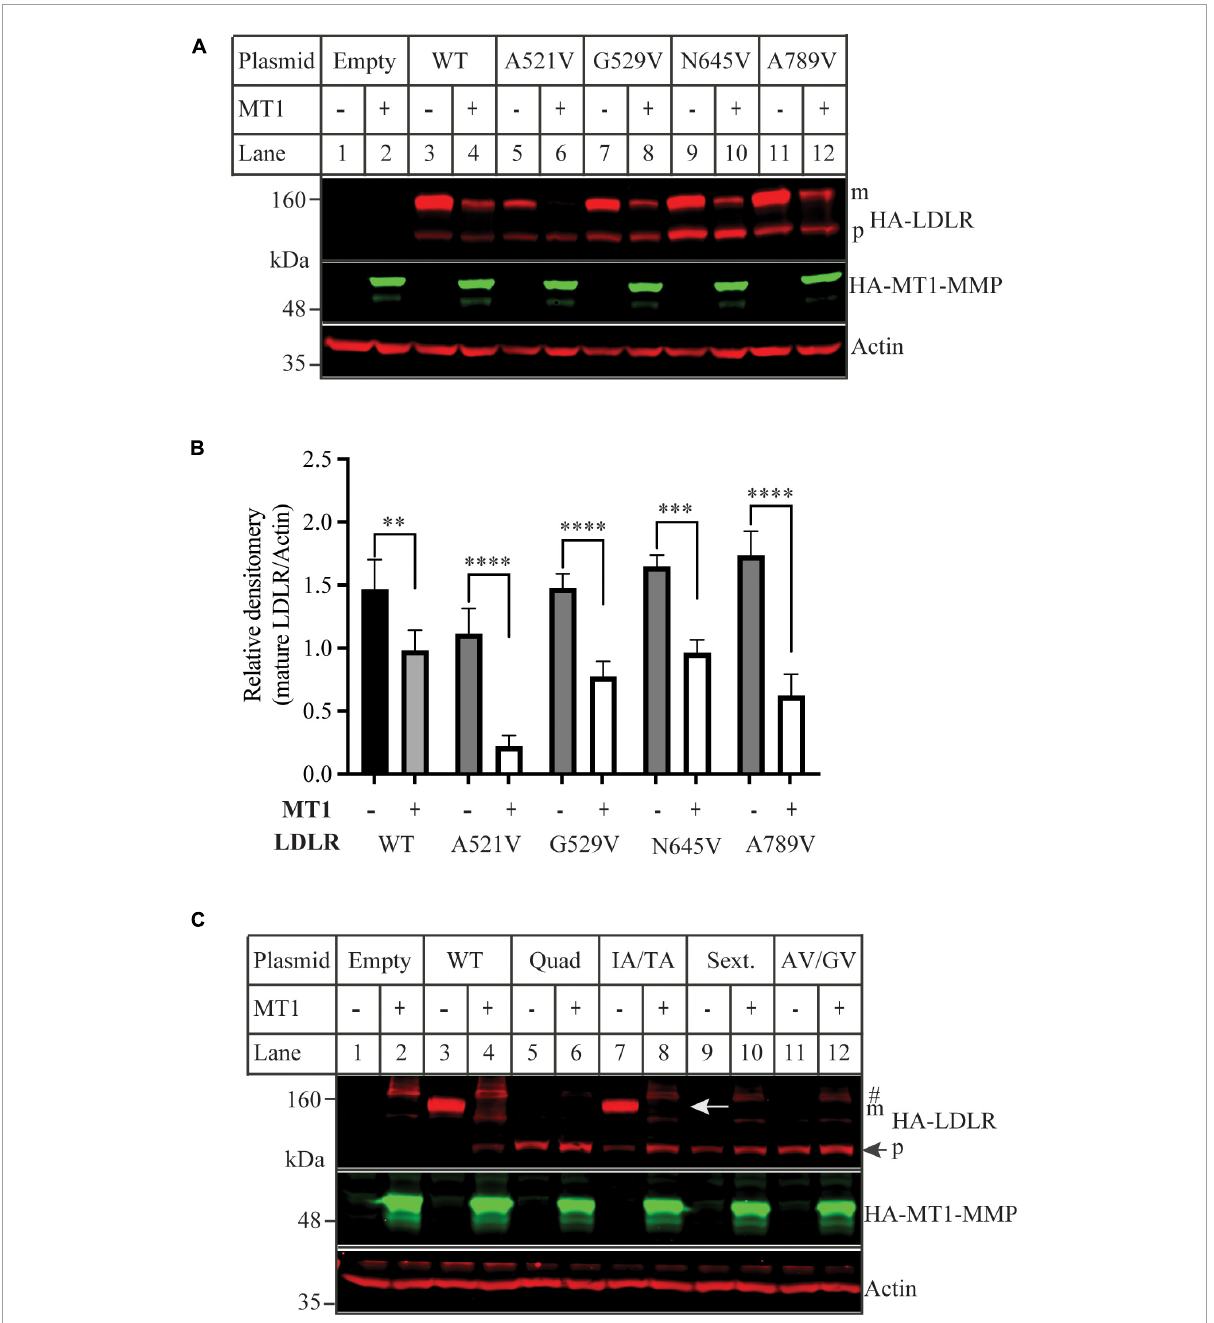
FIGURE2 Mutations of predicted MT1-MMP cleavage sites on LDLR (A,C) immunoblotting and (B) quantification. HEK293 cells were co-transfected with an equal amount of the wild-type (WT) or mutant LDLR and empty (-) or the wild type MT1-MMP (MT1) plasmid using PEI. 48 h later, whole cell lysate was isolated and applied to immunoblotting. After transfer, the membrane was cut into halves above the 75 kDa protein marker. HA-tagged LDLR on the top membrane was detected with a Dylight TM 680-conjugated rabbit anti-HA antibody (Rockland, 600-444-384). m: mature form of LDLR; p: premature form of LDLR. MT1-MMP on the bottom was detected by a Dylight TM 800-conjugated rabbit anti-HA antibody (Rockland, 600-445-384). Similar results were observed in three different experiments. Representative images were shown in (A,C) . Densitometry was determined by a Li-Cor Odyssey Infrared Imaging System. Relative densitometry was defined as the ratio of the densitometry of the mature form of wild-type or mutant LDLR to that of Actin at the same condition (B) . Values were mean ± S.D. of ≥ 3 experiments. Significance was defined as the mature form of LDLR in the presence of MT1-MMP vs. the mature form of LDLR in the absence of MT1-MMP. ** p < 0.01, *** p < 0.001, **** p <